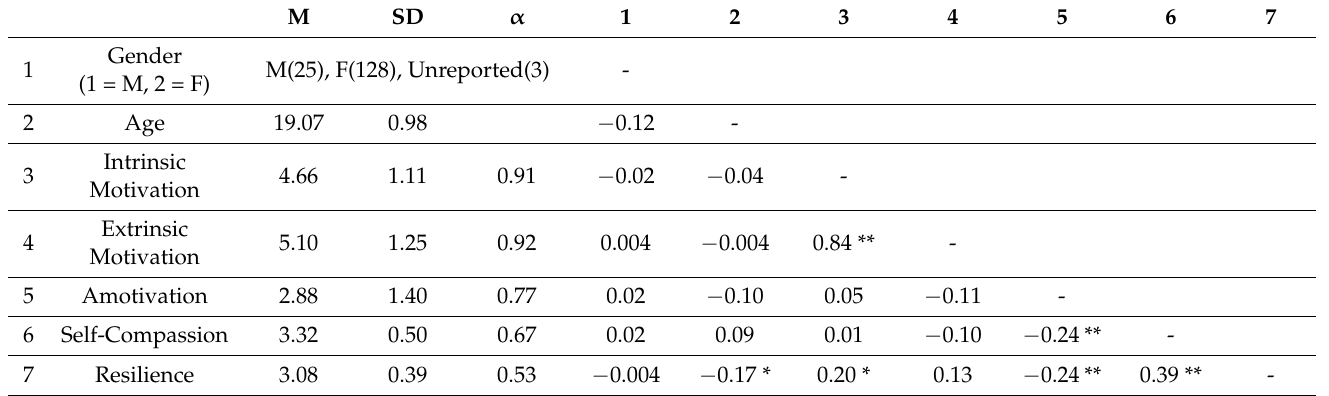
Table 1. Correlation among each type of academic motivation (intrinsic motivation, extrinsic motiva- tion and amotivation), self-compassion and resilience in 156 Indonesian students.